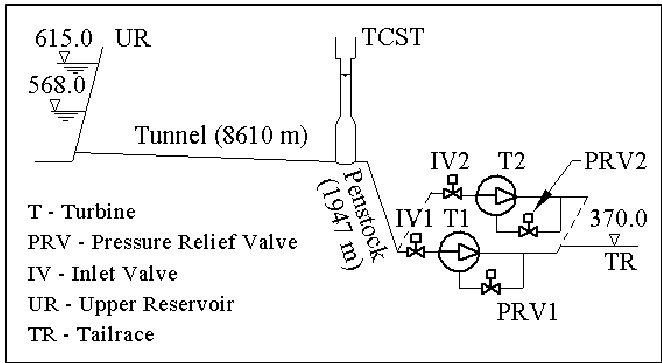
Figure 2. HPP Pirot scheme.